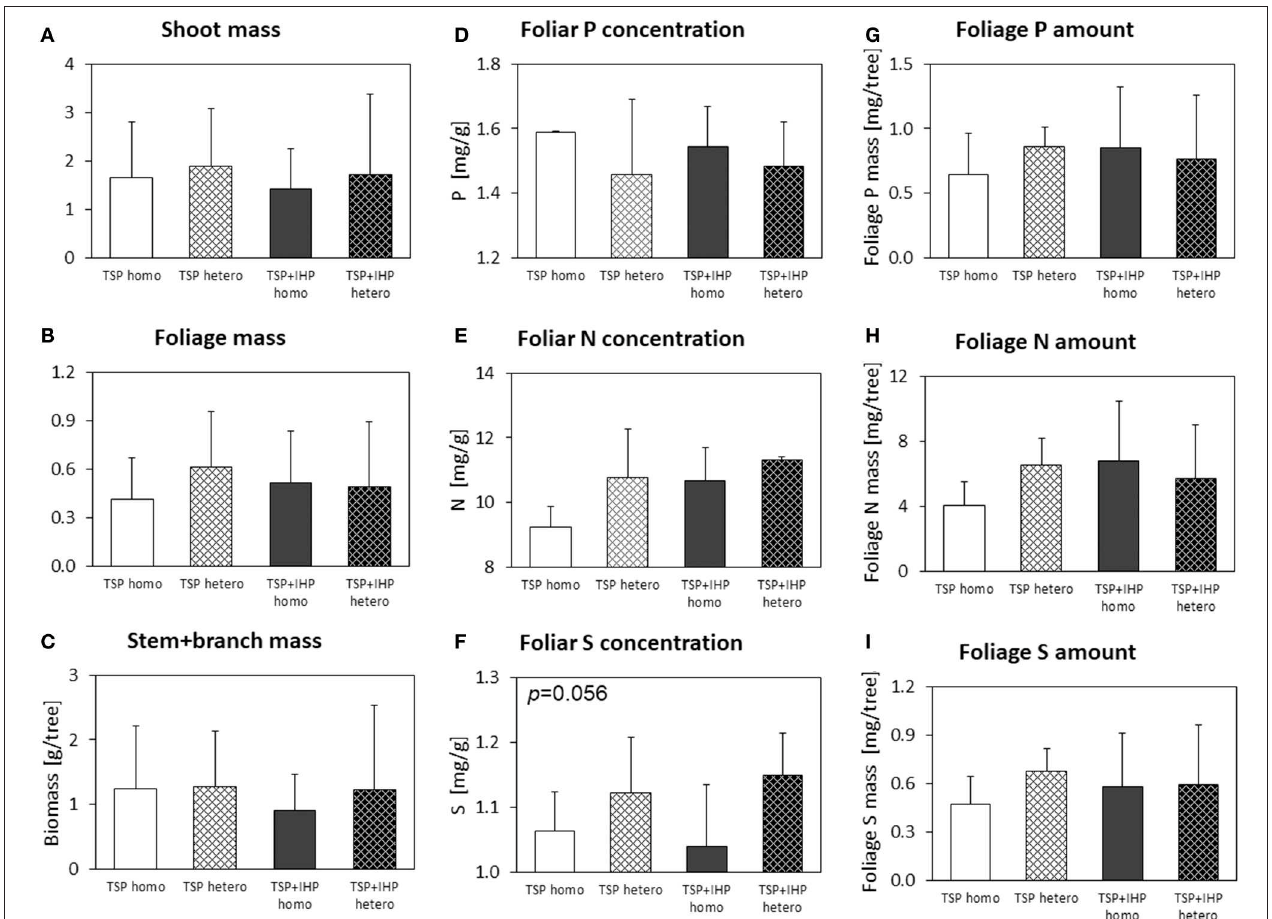
FIGURE 9 | Shoot (A) , foliage (B) , and stem + branch (C) biomass, foliar concentrations of N (D) , P (E) , and K (F) , and nutrient (P, N, K) amounts in foliage (G–I) of Fagus sylvatica at the moderate-P silicate site. Numbers in the upper left panel corner show p < 0.1 for differences between mean values of homogeneous vs. heterogeneous P application calculated by one-way